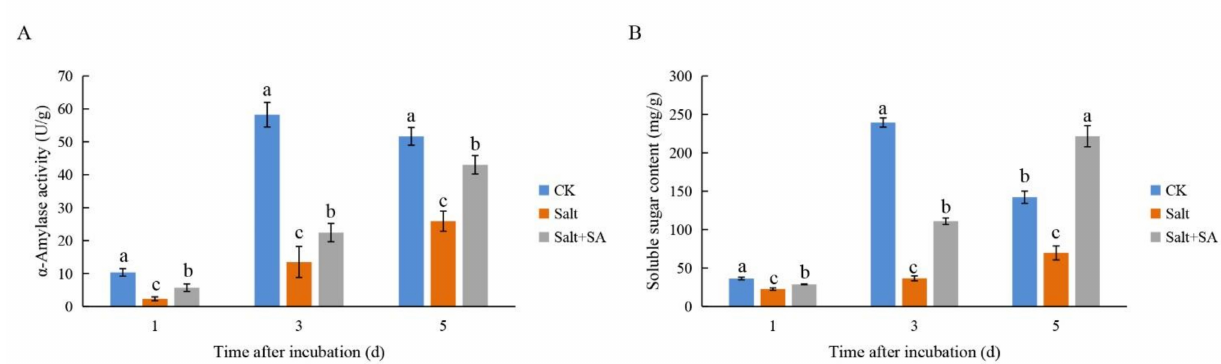
Figure 10. Effects of exogenous SA on α -amylase activity ( A ) and soluble sugar content ( B ) under salt stress. Seeds of Nipponbare were incubated in distilled water (CK), 150 mM NaCl (Salt), and 150 mM NaCl + 0.1 mM SA (Salt + SA) for 1, 3, and 5 days. Data are presented as means ± SE. Different lowercase letters indicate significant differences between treatments ( p <